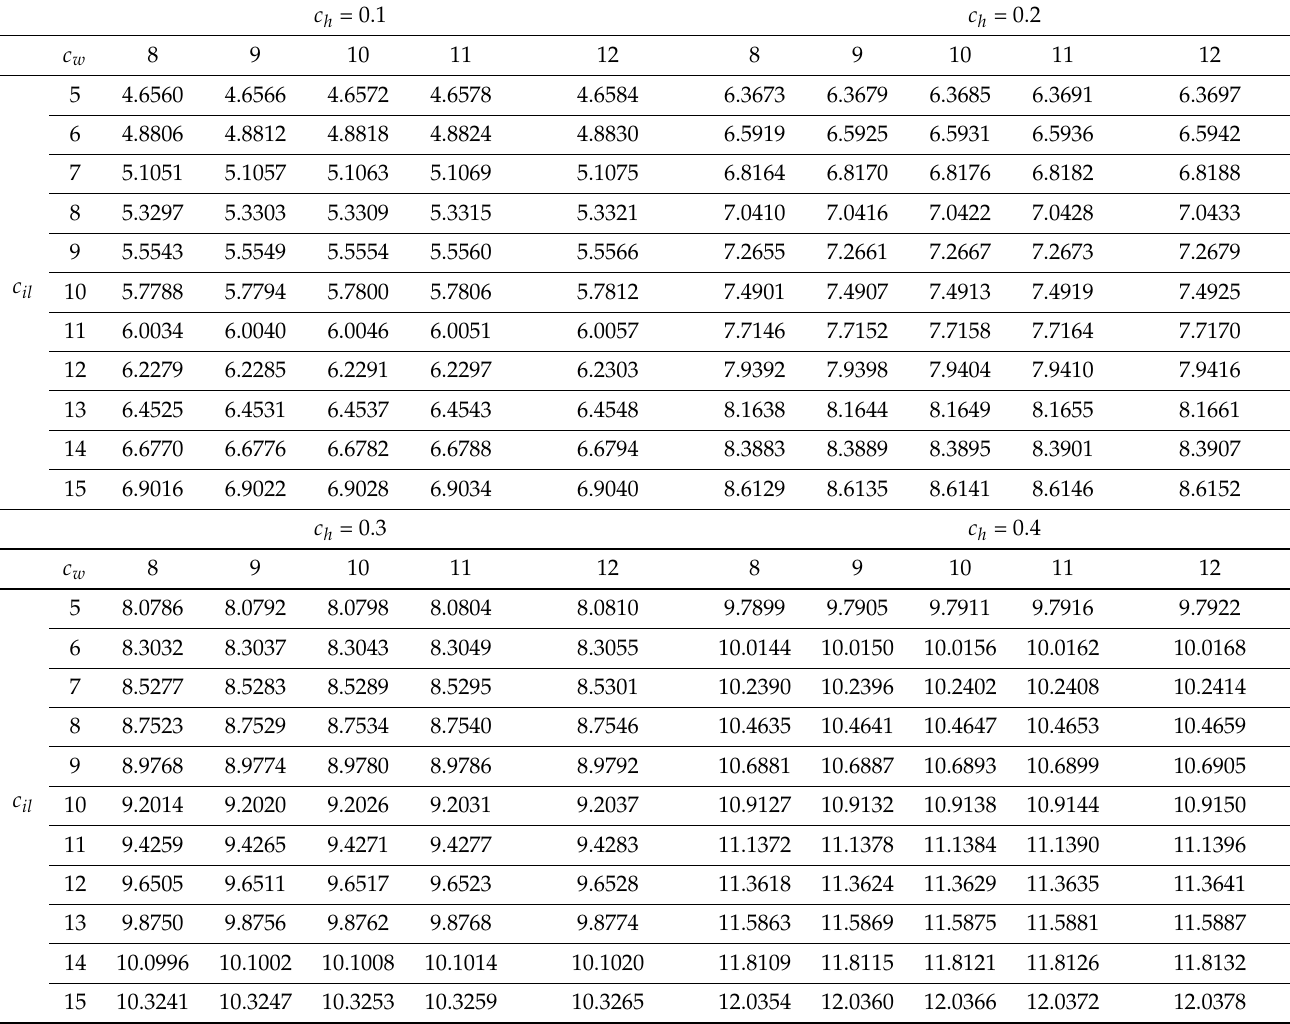
Table 4. Total expected cost values for different cost